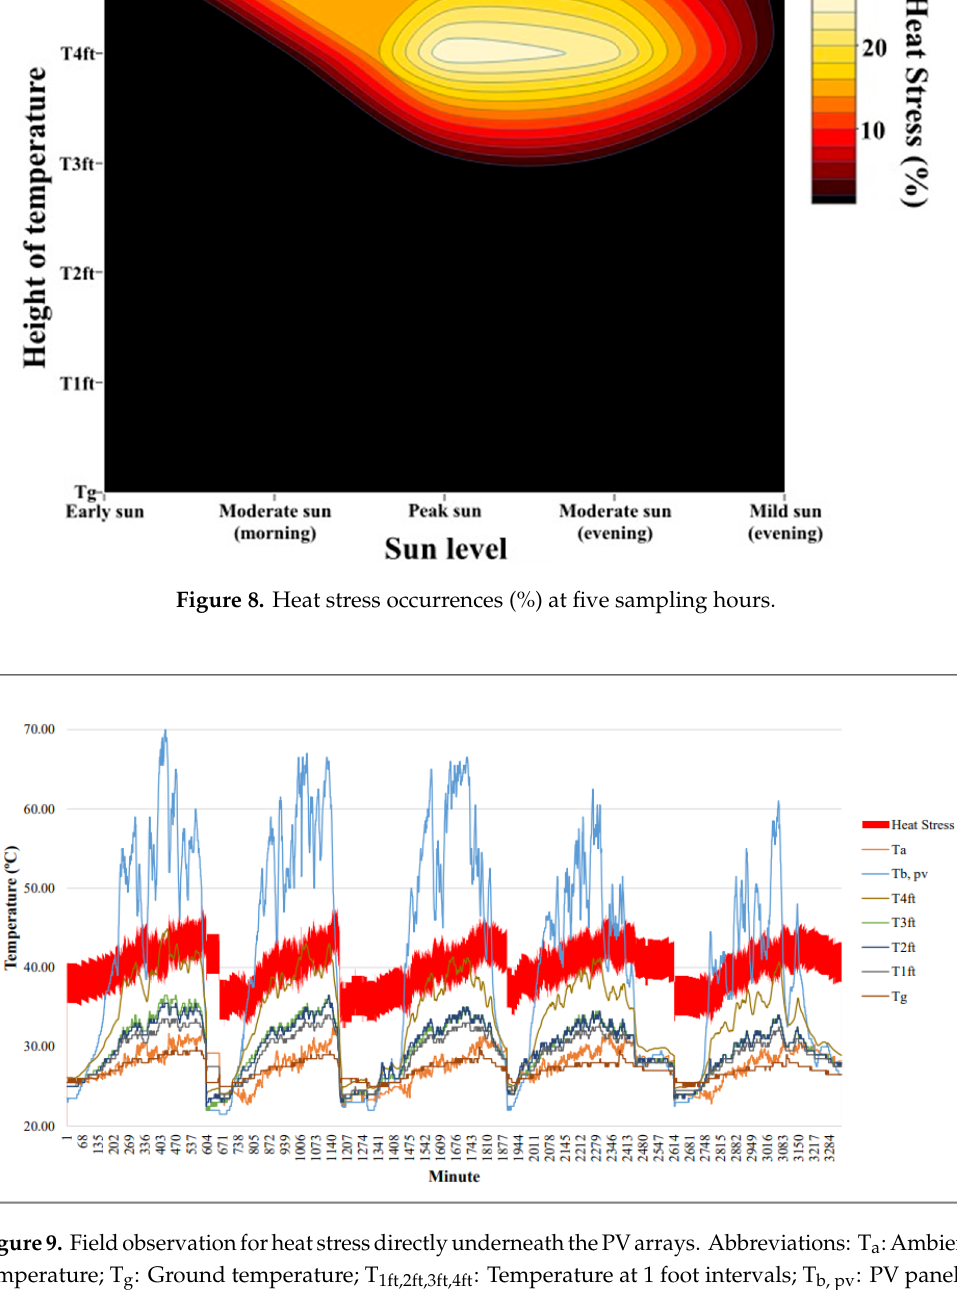
Figure 9. Field observation for heat stress directly underneath the PV arrays. Abbreviations: T a : Ambient temperature; T g : Ground temperature; T 1ft,2ft,3ft,4ft : Temperature at 1 foot intervals; T b, pv : PV panel's bottom surface temperature.